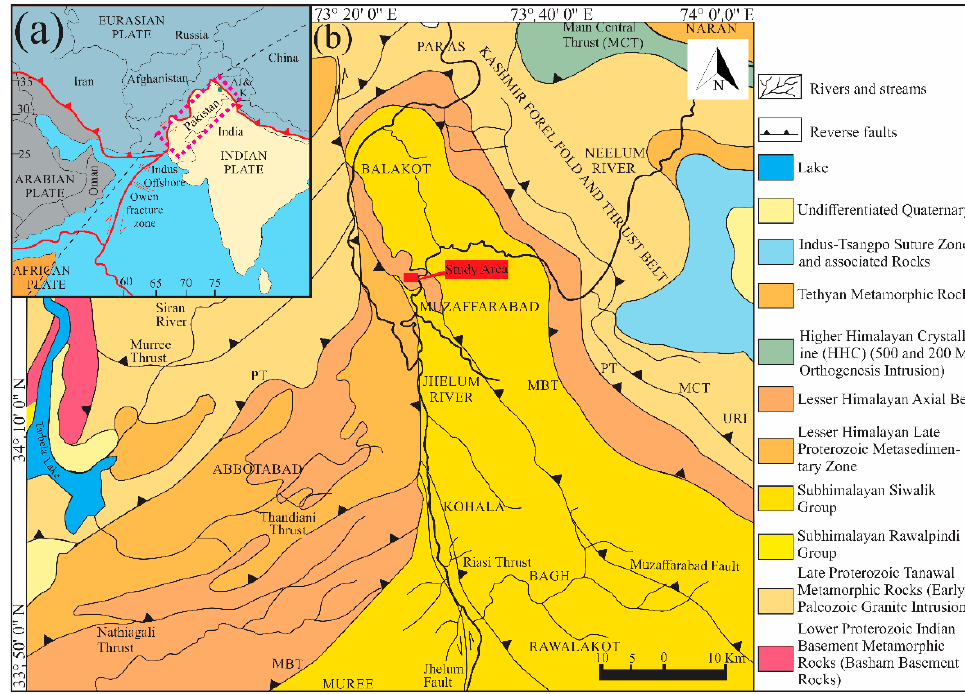
Figure 1. ( a ) Inset shows the regional location of Indus Basin in Pakistan with the dotted purple line; ( b ) study area of the Yadgaar Section in the UIB.